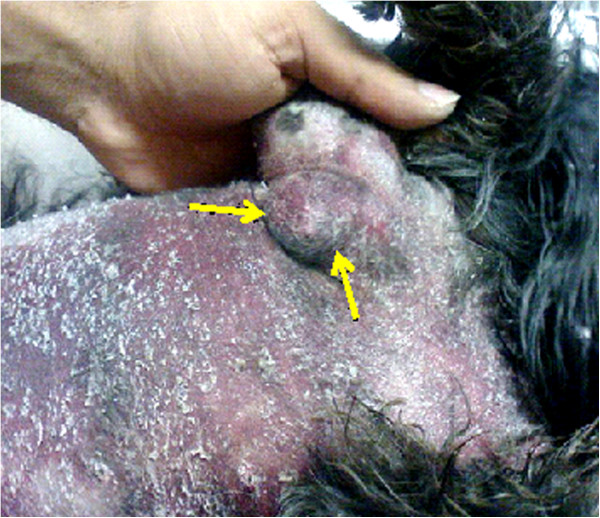
Macroscopical examination of a cutaneous cell tumor in a black terrier. The mass spreading into subcutis is of proximal right front leg.